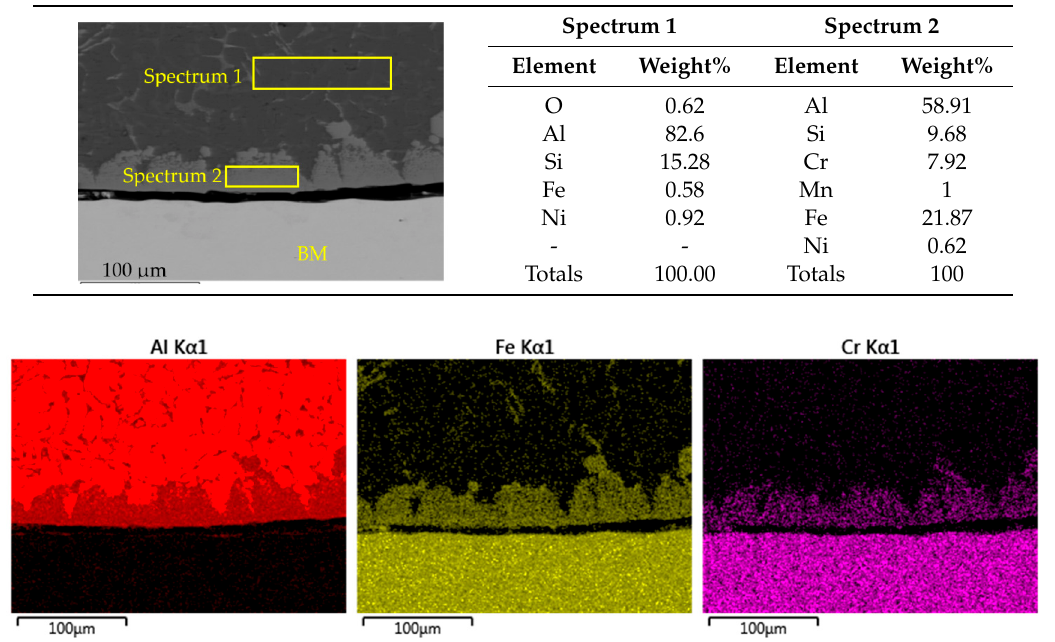
/ 680 ± 20 ◦ C / 120 min / ENAC-AlSi9. EDX semi-quantitative microanalyses Figure 24. BM/680 ± 20 °C/120 min/ENAC-AlSi9. EDX semi-quantitative microanalyses (mapping). Figure 24. BM Figure 24. BM/680 ± 20 °C/120 min/ENAC-AlSi9. EDX semi-quantitative microanalyses (mapping). Figure 24. BM/680 ± 20 °C/120 min/ENAC-AlSi9. EDX semi-quantitative microanalyses (mapping).